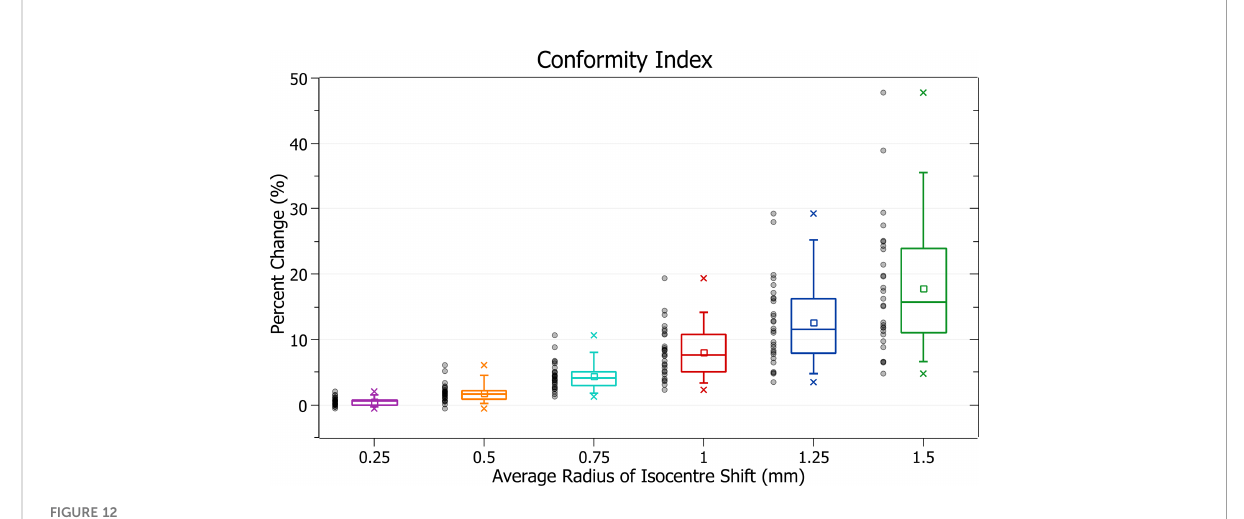
FIGURE 12 Percentage change of conformity index for different radii of isocentre shift.